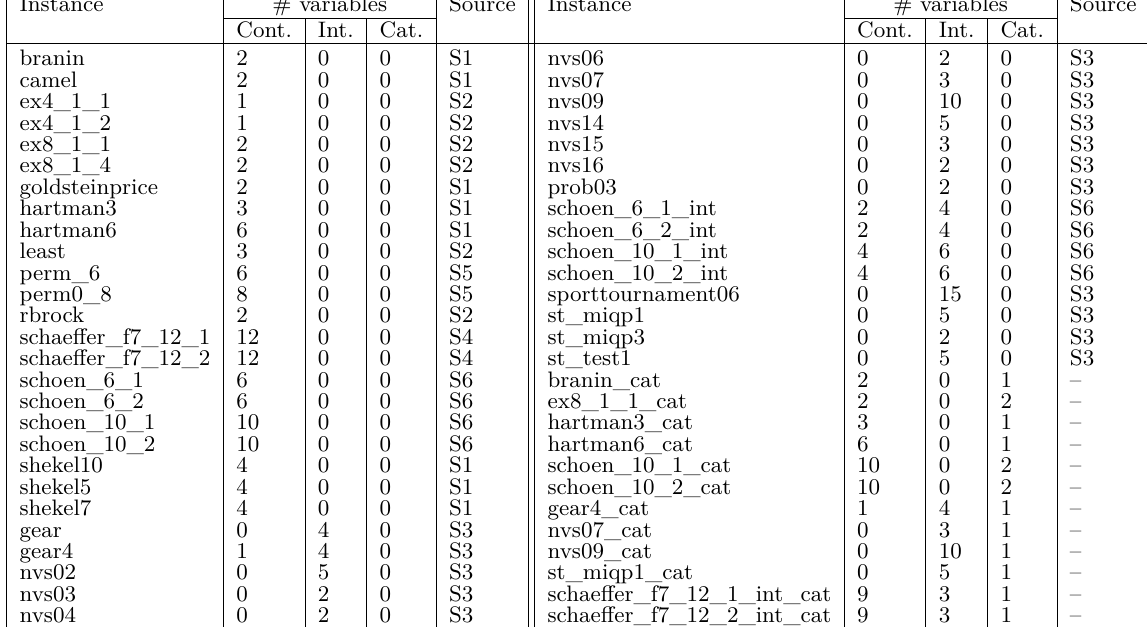
Table 2 Details of the instances used for the tests. Legend for the sources: S1 is Dixon–Szegö [12], S2 is the original GLOBALLIB, S3 is the MINLPLib 2 [22], S4 is [35], S5 is Neumaier’s website [26], S6 denotes Schoen’s smooth functions [36]. The functions with no indicated source are discussed in the main